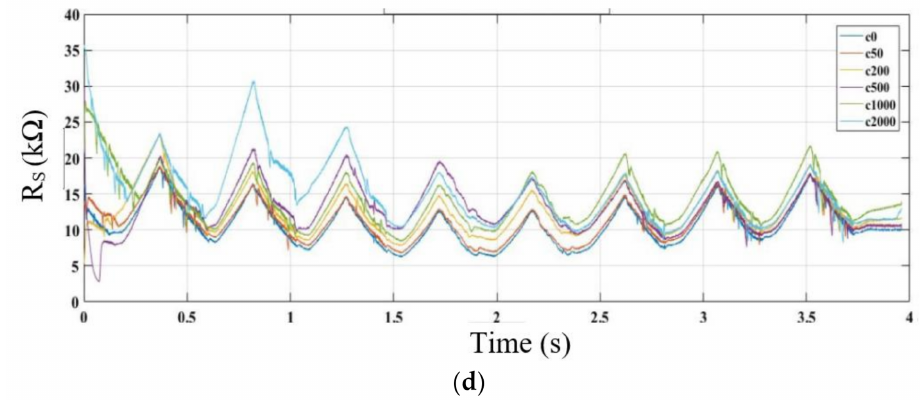
Figure 6. Two-dimensional plots of gas sensor response R S against time at different temperatures, humidity, and concentration levels of ethanol solution (c0, c50, c200, c500, c1000, and c2000): ( a ) MiCS- 5524, ( b ) GM-402B, ( c ) GM-502B, and ( d ) MiCS-6814.